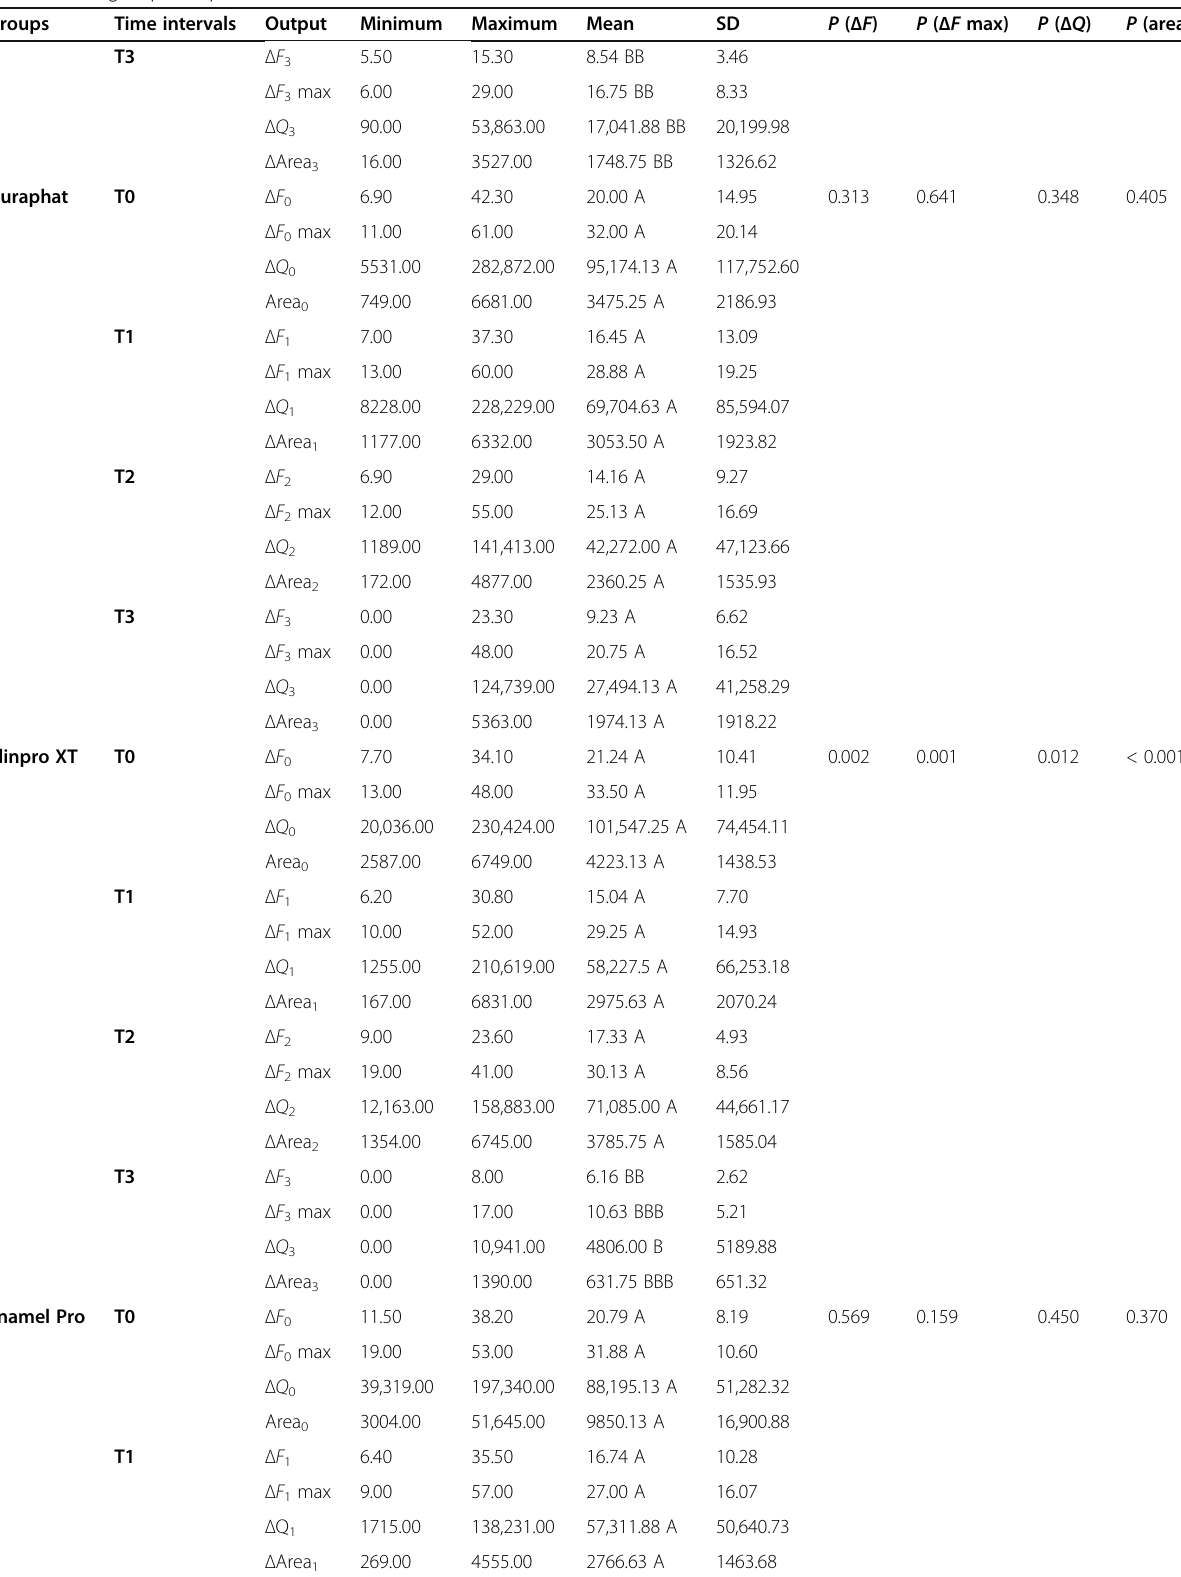
Table 2 Intragroup comparisons of QLF scores between timeline intervals (Continued)